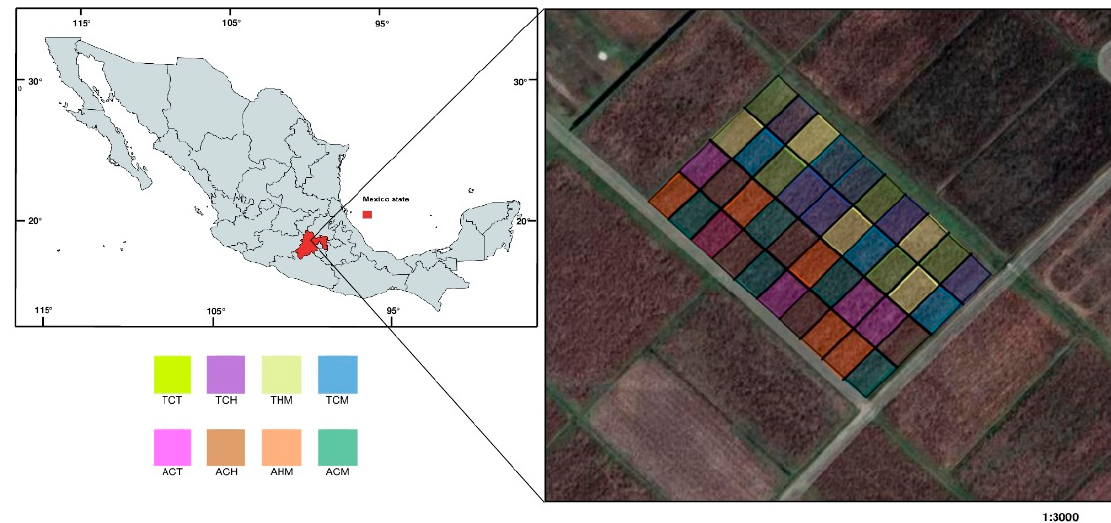
Figure 1. Location map of the experimental area. TCT, tractor unfertilized control; TCH, tractor chemical fertilizer; THM, tractor horse manure; TCM, tractor chicken manure; ACT, animal unfertilized control; ACH, animal chemical fertilizer; AHM, animal horse manure; ACM, animal chicken manure. Table 1. Management practices for corn cultivation during 2020.